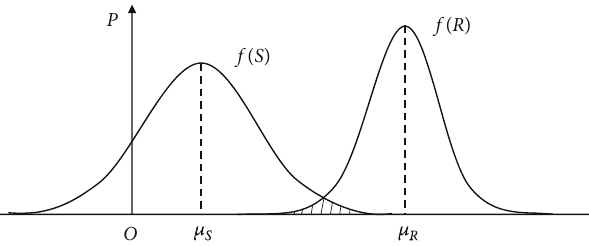
Figure 2: Probability density function of structural resistance R and total load S